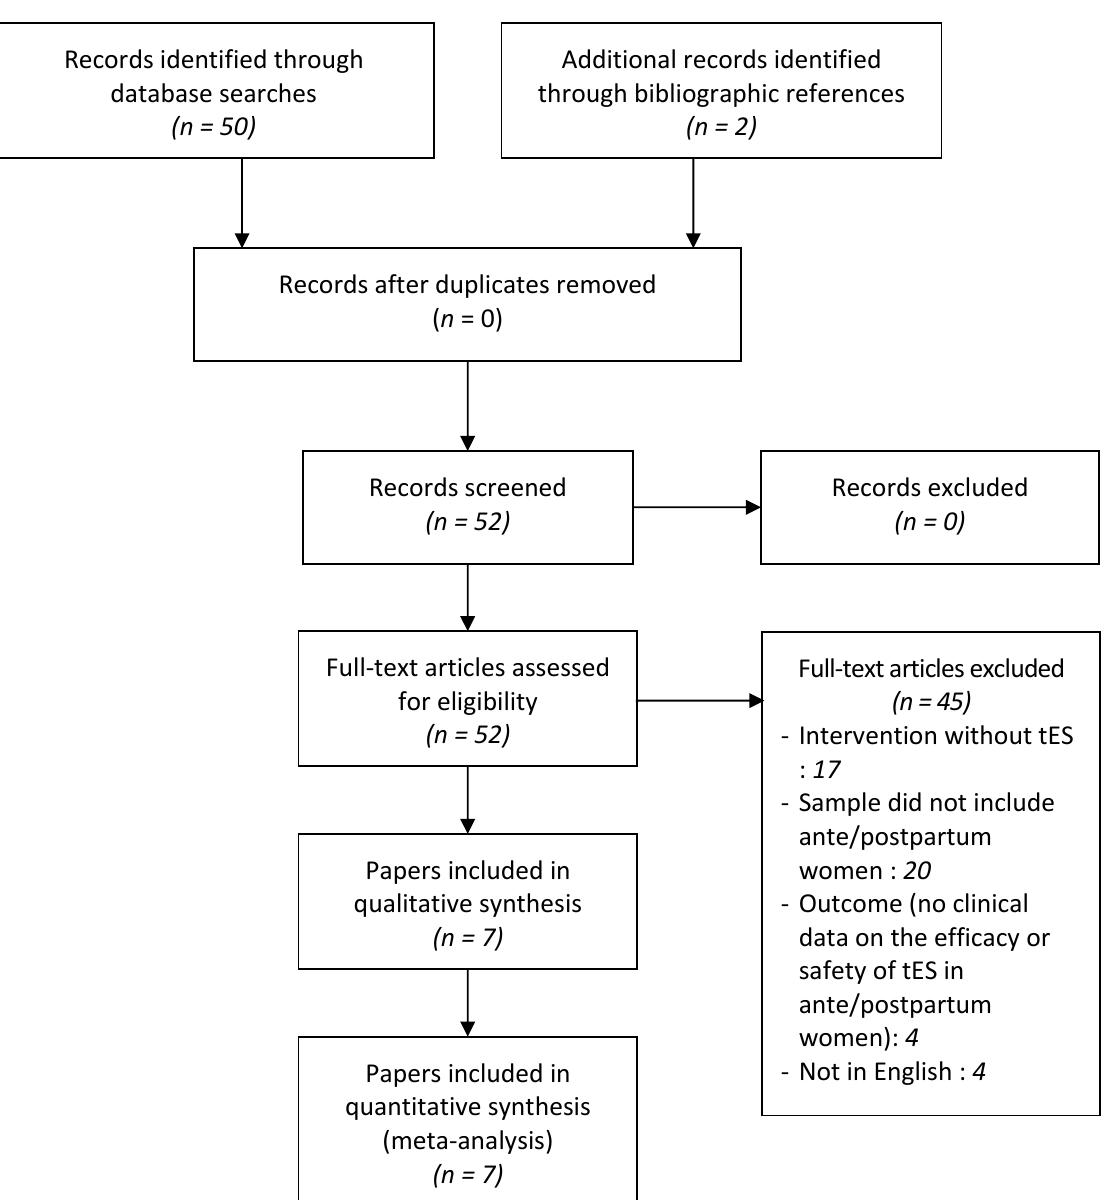
Figure 1. Adapted PRISMA flow diagram. tES : transcranial electric stimulation .